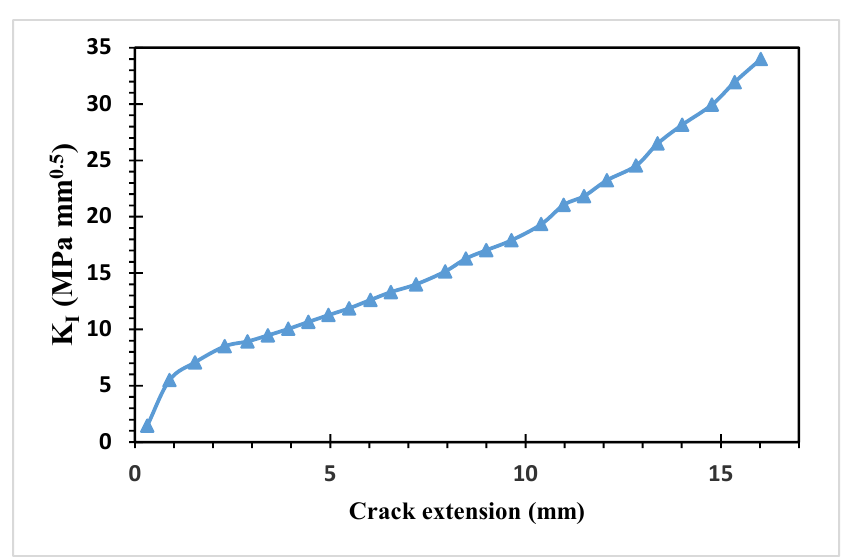
Figure 19. First mode of stress intensity factors.